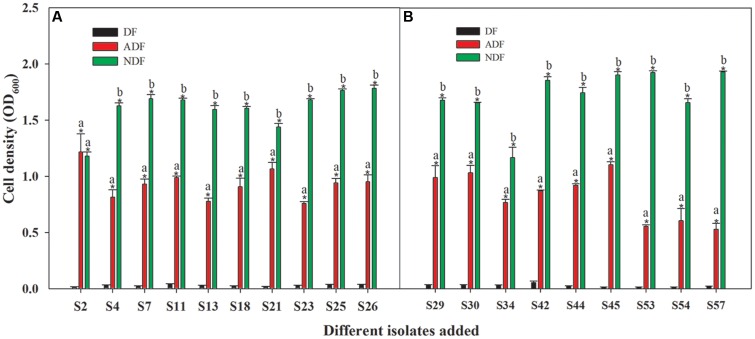
Capacity for growth of 19 Cu/Zn-resistant isolates on ADF (A,B). Different small letters denote significant differences between treatments and an asterisk (∗) represents a significantly greater value on ADF and NDF compared to DF (P < 0.05).